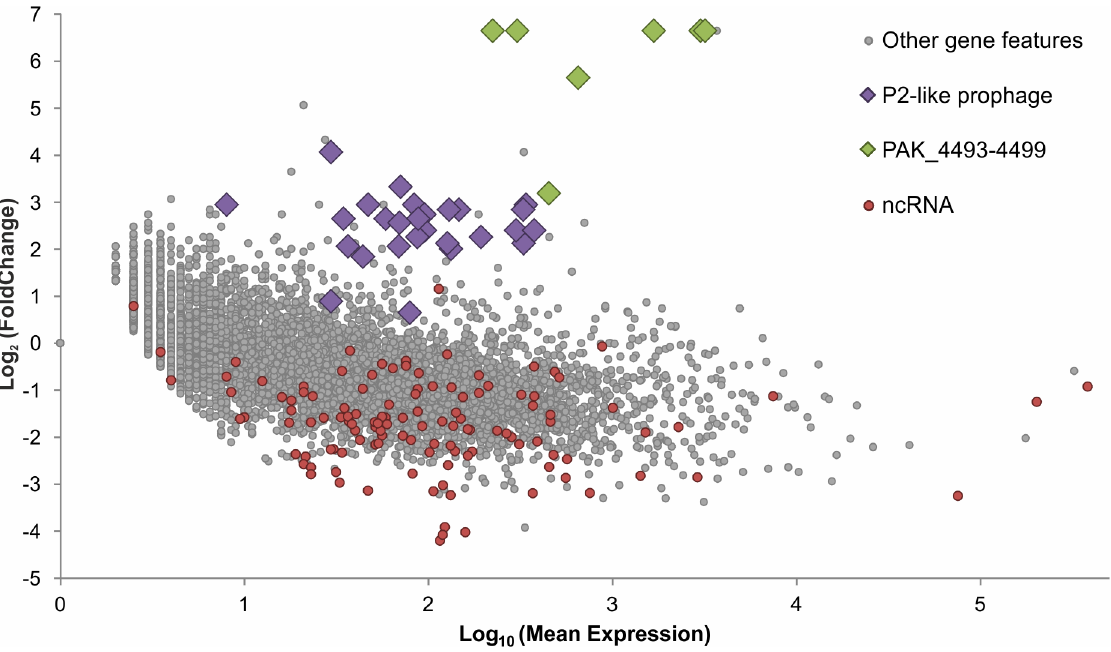
Fig 3. PAK_P3 alters expression of many host gene features by late infection. Differential expression analysis of host gene features comparing transcript abundance between phage negative controls (t = 0 min) and late infection (t = 13min) was performed. This comparison was made after normalizing the read counts that map to each host gene feature between both conditions, ignoring reads that map to the phage, which artificially enriches reads in the late condition. This method thus compares the negative control directly to a host transcript population that has been depleted by replacement with phage transcripts during infection, normalizing away the global depletion so that more specific shifts can be reported and independently tested